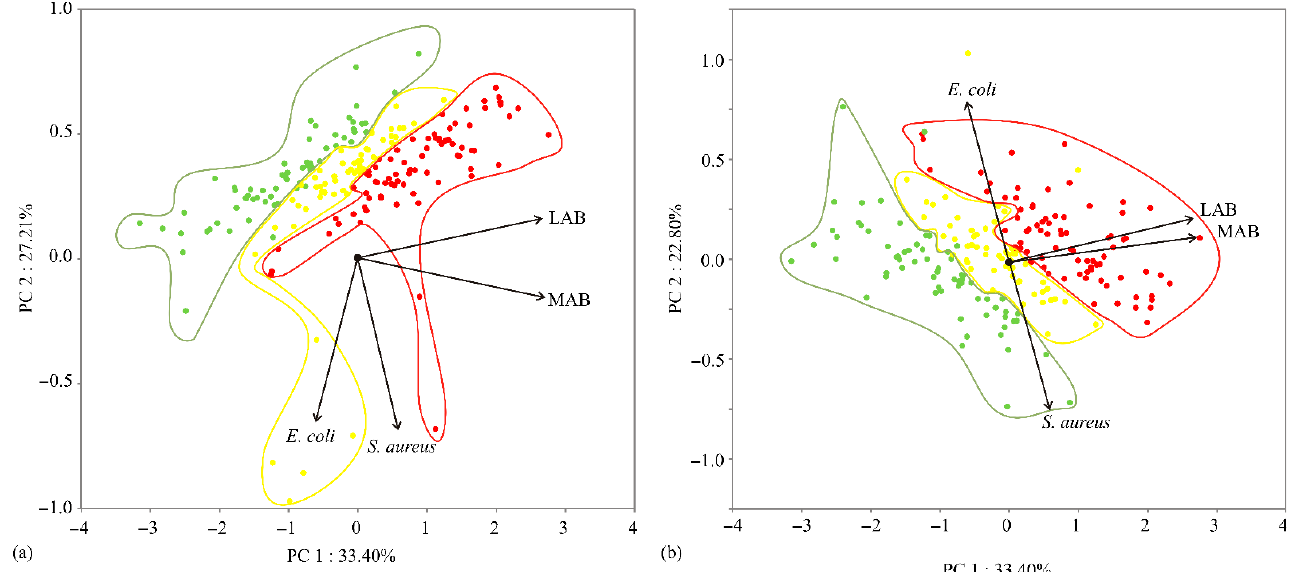
Figure 2. PCA ordination of variables based on component correlations: ( a ) projection in PC1-PC2 plane, ( b ) projection in PC1-PC3 plane for mesophilic and aerobic bacteria (MAB), E. coli , lactic acid bacteria (LAB), and S. aureus . Table 3. ANN summary or observed